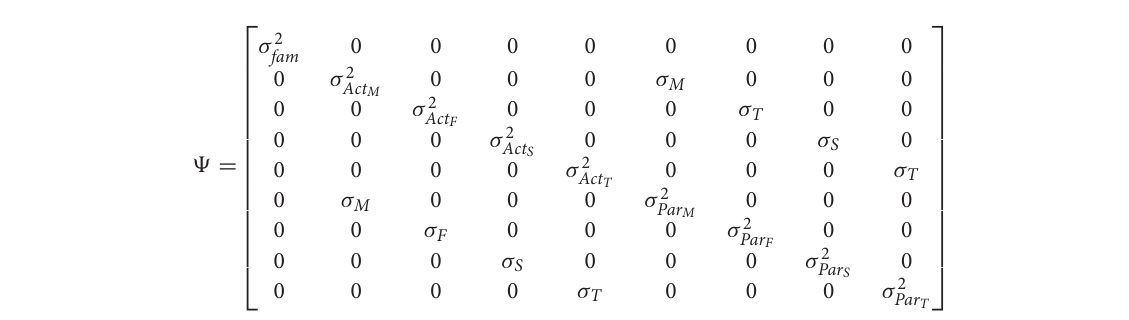
FIGURE 1 | The family social relations model ( M , mother; F , father; T , target adolescent; S ,